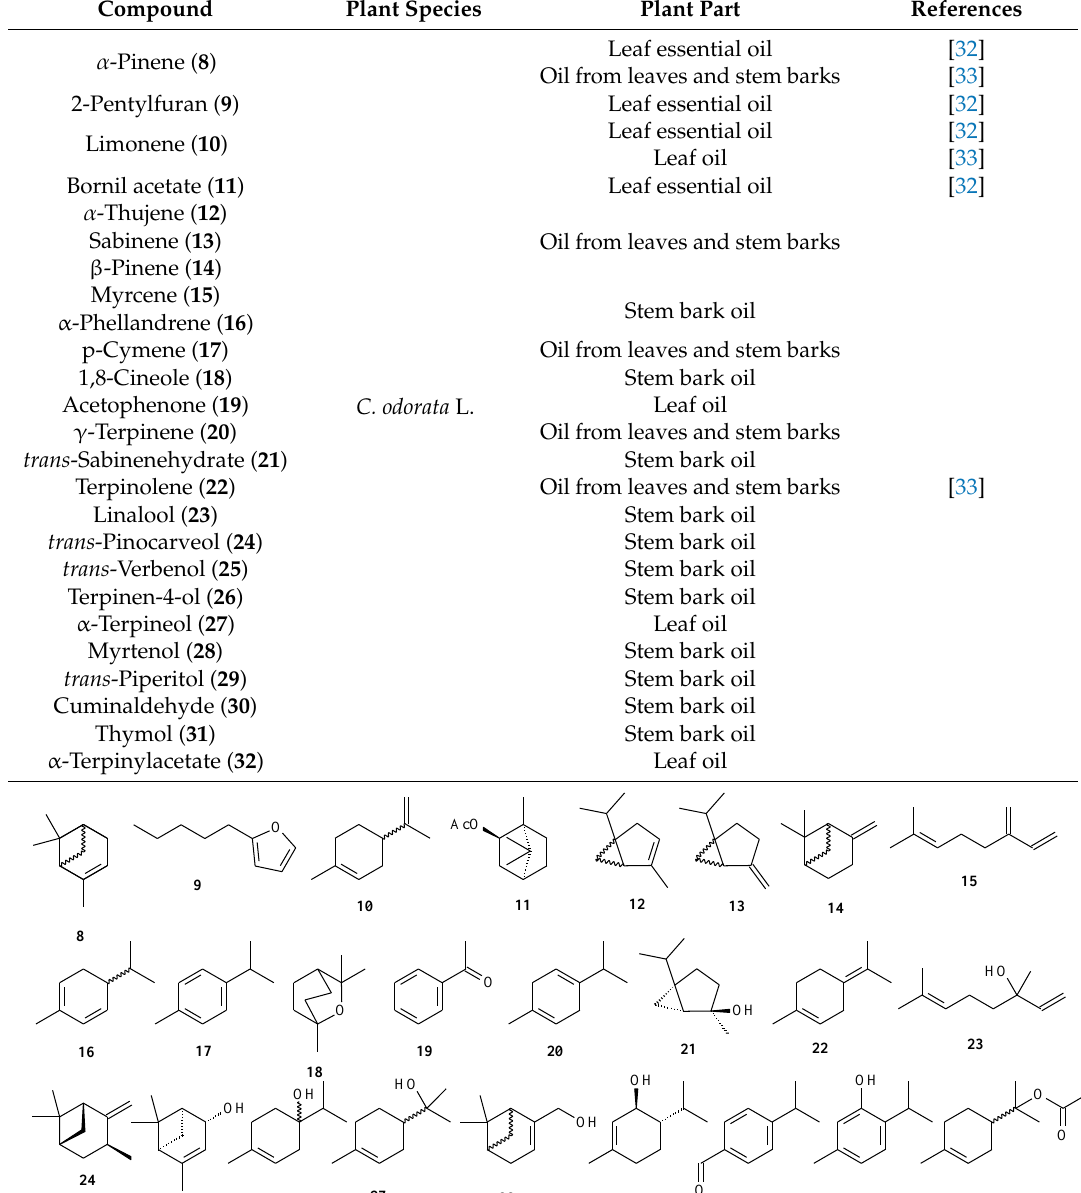
Table 4. Monoterpenes identified from the genus Cedrela (1960–2020).